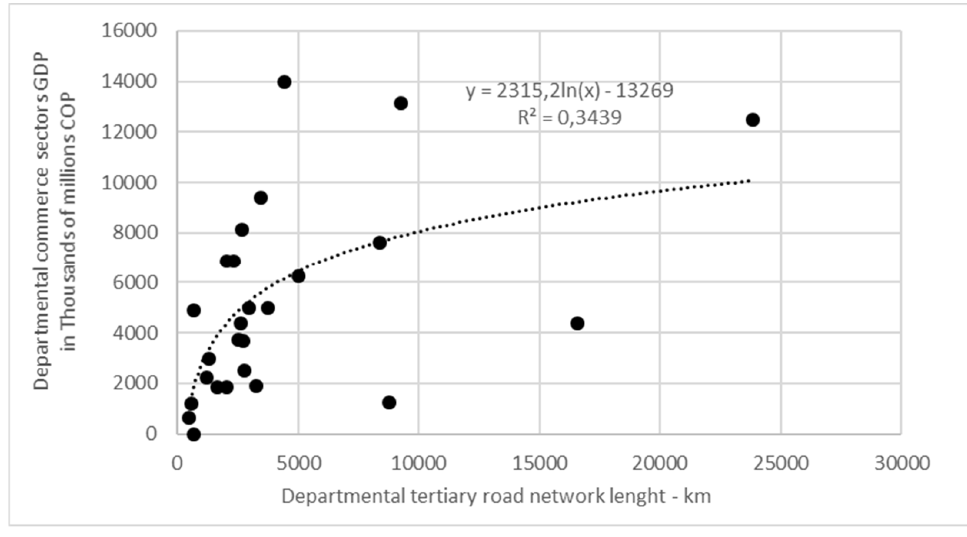
Figure 9. Logarithmic regression between commerce sector GDP and tertiary roadway network, according to the department.